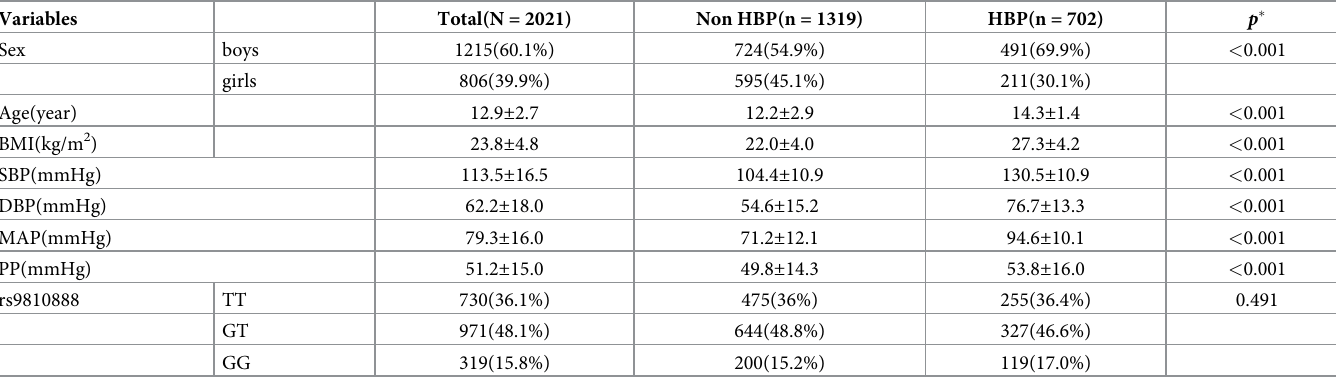
Table 1. General characteristics and behavior characteristics of the study population.